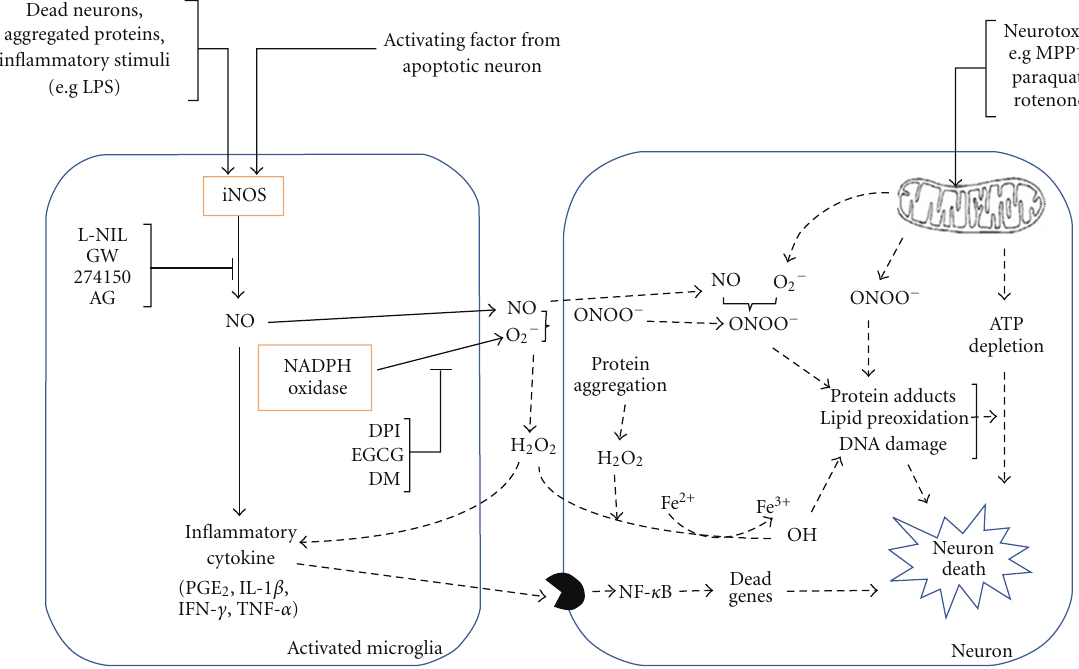
Figure 7: Role of iNOS and NADPH oxidase and their inhibitors in oxidative stress and neuronal damage. Reactive oxygen species (ROS) can be generated in distinct ways, for example, cell activation by neurotoxins (MPTP, paraquat, and rotenone), and mitochondrial dysfunction and protein aggregation. ROSs have a role in oxidative stress, thereby causing neuronal injury or cell death which can be a factor for microglial activation. Several inhibitors of iNOS (L-N-iminoethyl-lysine (L-NIL), GW 274150, and aminoguanidine (AG)) and NADPH oxidase inhibitors diphenyliodonium (DPI), epigallocatechin (EGCG), and dextromethorphan (DM) as shown inhibit the generation of nitric oxide and superoxides, thereby inhibiting the formation of ROS and preventing neurodegeneration. Abbreviations: iNOS: inducible nitric oxide synthase, LPS: lipopolysaccharides, NADPH oxidase: nicotinamide adenine dinucleotide phosphate-oxidase, NO: nitric oxide, O 2 − : peroxy radical, ONOO − : peroxynitrite, NF- κ B: nuclear factor kappa, H 2 O 2 : hydrogen peroxide, TNF- α : tumor necrosis factor-alpha, PGE 2 : prostaglandin E2, IL-1 β : interleukin-1 beta, and IFN- γ :